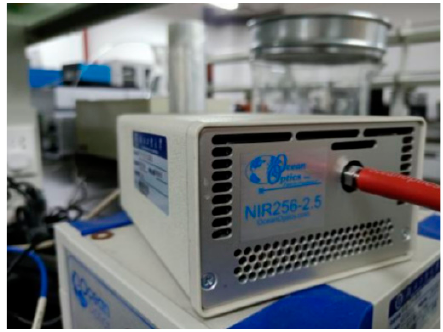
Figure 2. Near-infrared spectrometer. Table 1. Instrument parameter table.